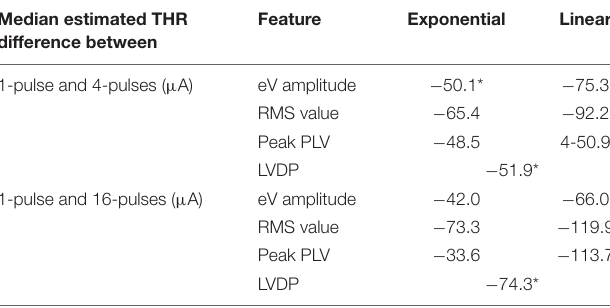
TABLE 2 | Median estimated threshold (THR) differences for different features and fitting functions. Median estimated THR Feature Exponential difference between